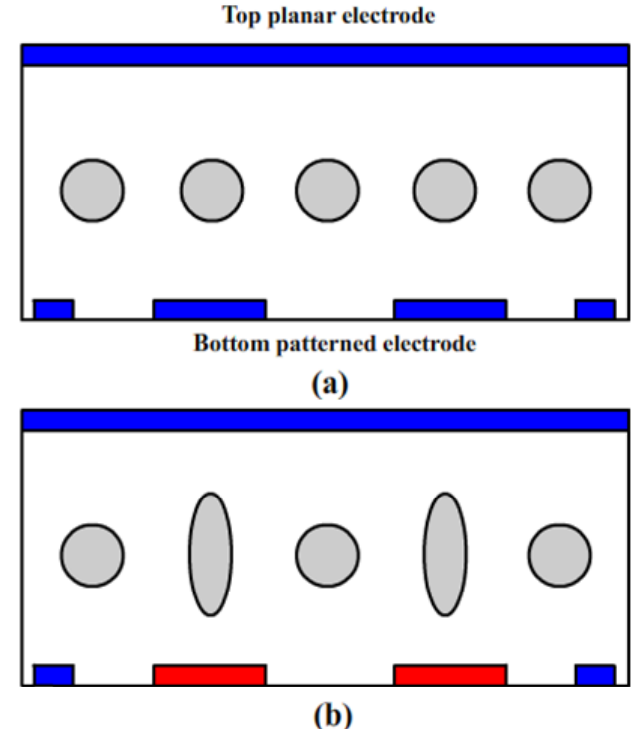
Figure 17. Schematic of experimental setup for making a Fresnel BPLC lens by